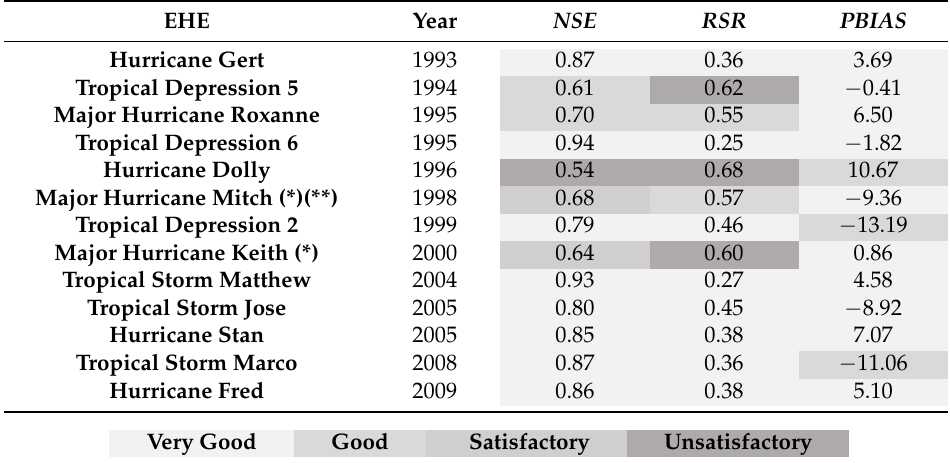
Very Good Good Satisfactory Unsatisfactory Notes: (*) Entered land and/or affected Mexico and (**) other